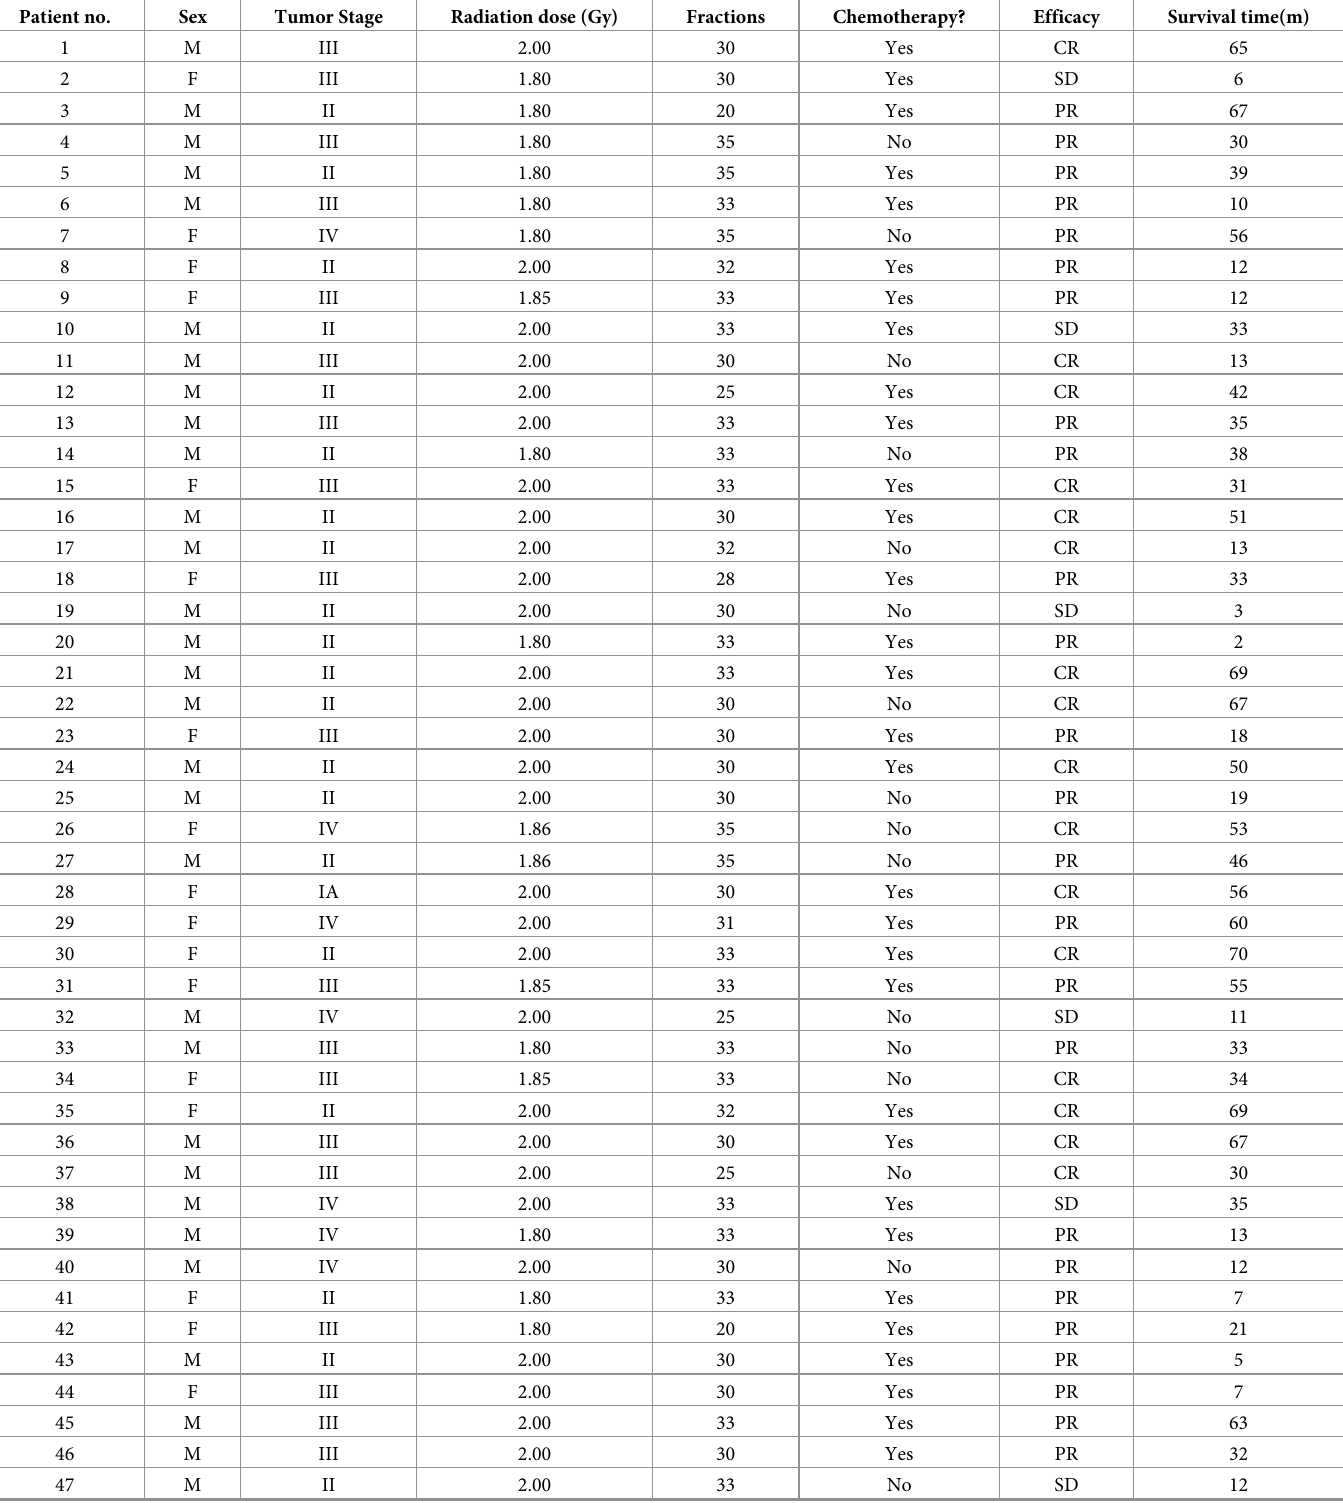
Table 1. Patient characteristics, treatment methods and outcome data. Patient